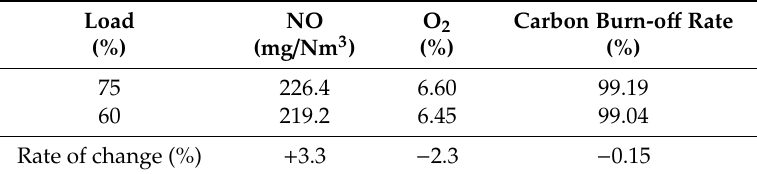
Table 4. Important parameters of furnace outlet at standard state.